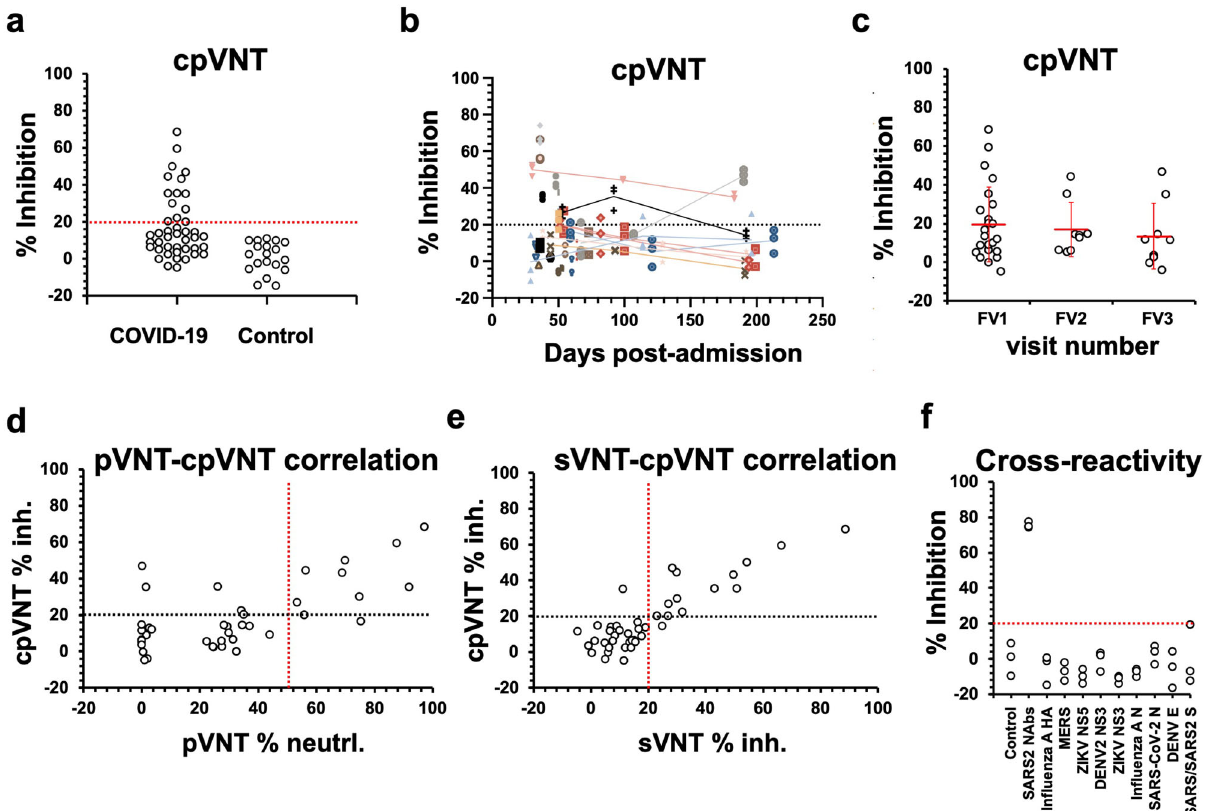
Fig. 4 Evaluation of neutralizing antibodies (NAb) status from COVID-19 convalescent samples, at different time points post infection, from different follow up visits (FV) using cellulose pull-down virus neutralization test (cpVNT). a NAbs from all samples and visits as compared to pre-COVID plasma samples. Cut-off value which distinguished positive from negative NAb levels was designated at 20% inhibitory percentage (red line). Each data point represented mean value of % inhibition of different samples. Each point was performed in triplicates. b NAbs detection using cpVNP from different samples at different time points. Data were represented as mean ± standard deviation (SD). Each data point was performed in triplicates. Lines connecting different data points represented signals obtained from the same sample at different time points. c Alternative presentation of NAbs detected from different visits. Each data point represented mean value of % inhibition obtained from different samples. Each point was performed in triplicates. d Correlation between cpVNT and pseudovirus neutralization test (pVNT). Black and red lines represent cut-off values at 20% and 50% for cpVNT and pVNT, respectively. Each data point represented mean value of % inhibition or % neutralization for cpVNT and pVNT, respectively. Each point was performed in triplicates. e Correlation between cpVNT and surrogate virus neutralization test (sVNT). Black and red lines represent cut-off values at 20% for cpVNT and pVNT. Each data point represented mean value of % inhibitions for cpVNT and pVNT. Each point was performed in triplicates. f Cross reactivity test of cpVNT using antibodies against different viruses or viral antigens spiked in healthy plasma samples. Red line represents a cut-off value at 20%. Each data point represented % inhibition from a single cpVNT experiment. Three separate experiments were performed for each